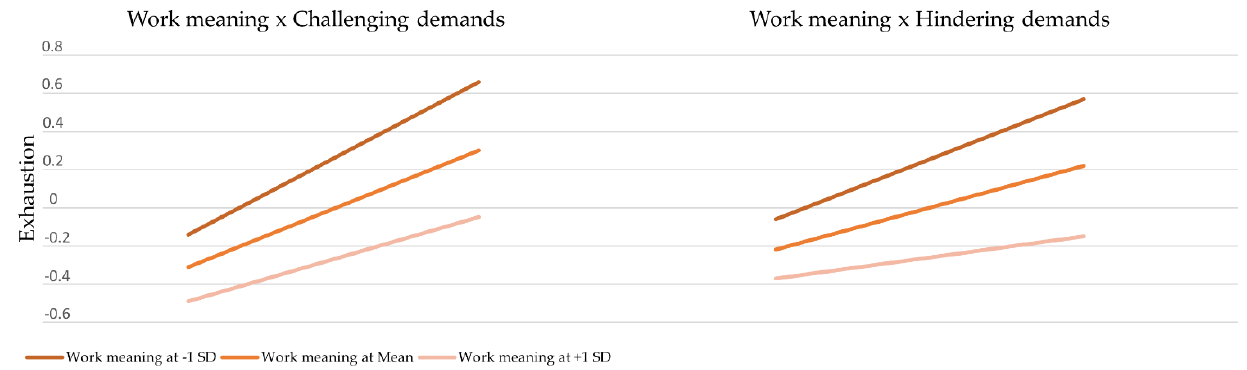
Figure 3. Interaction between work meaning and job demands predicting Figure 3 - Interaction between work meaning and job demands predicting exhaustion. Table 5. Hypotheses summary.